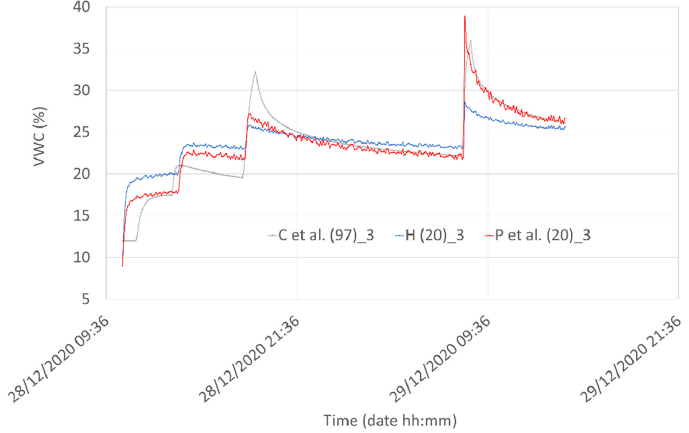
Figure 21. Comparison among the best results obtained from the correlation procedure for the three considered models.